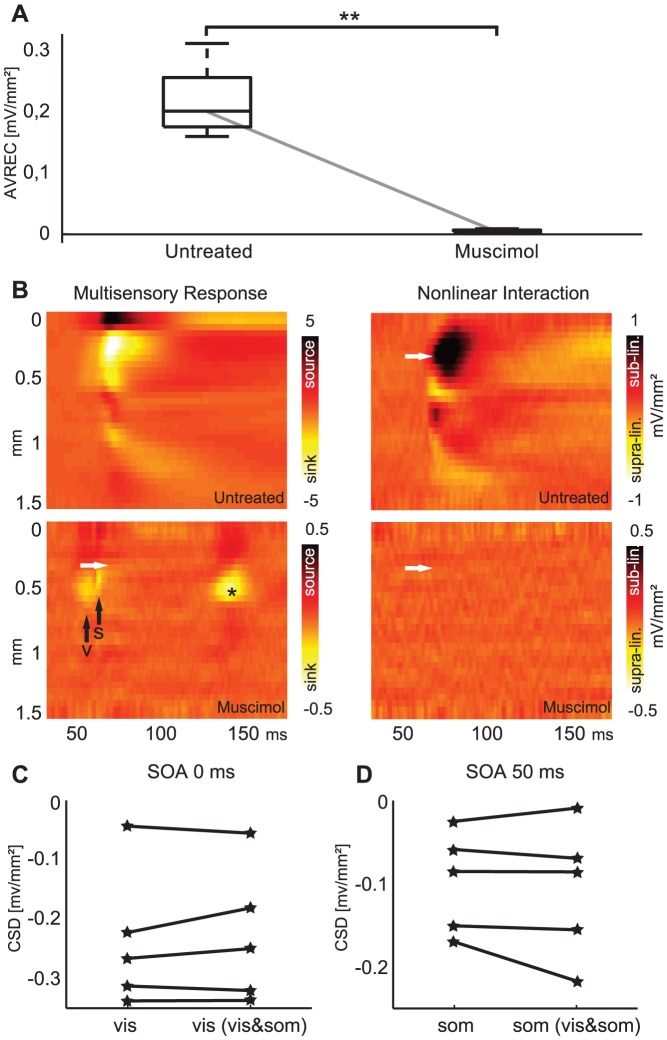
Pharmacological suppression of local activity abolishes non-linear interactions.A: General decrease in average rectified current source density (AVREC) caused by muscimol application (100 ms post-stimulus window, mean of both unisensory stimuli, n = 5, P<0.05, U test). B: Example data showing the bimodal response (vis&som) and the non-linear interaction (vis&som – (vis+som)) for the SOA = 50 ms condition before (upper panel) and after application of muscimol. In the untreated condition, the previously noted pattern of current sinks (left) and sub-linear multisensory interactions are visible (white arrow, right panel). After muscimol application, individual feed-forward current sinks related to visual (arrow V) and somatosensory (arrow S) inputs are apparent, as well as a late additional visual sink (*, bottom left panel). The multisensory interaction is negligible, indicating a linear superposition of responses. Note the different scales in upper and lower panels. C: Peak amplitudes of the visual granular sink during unisensory (vis) and multisensory stimulation (vis (vis&som)) after muscimol treatment do not differ, demonstrating the absence of non-linear interactions. D: Peak amplitudes of the somatosensory granular sink in unisensory (som) and multisensory stimulation (som (vis&som)) after treatment also do not differ, favoring a cortical origin of the observed interactions.